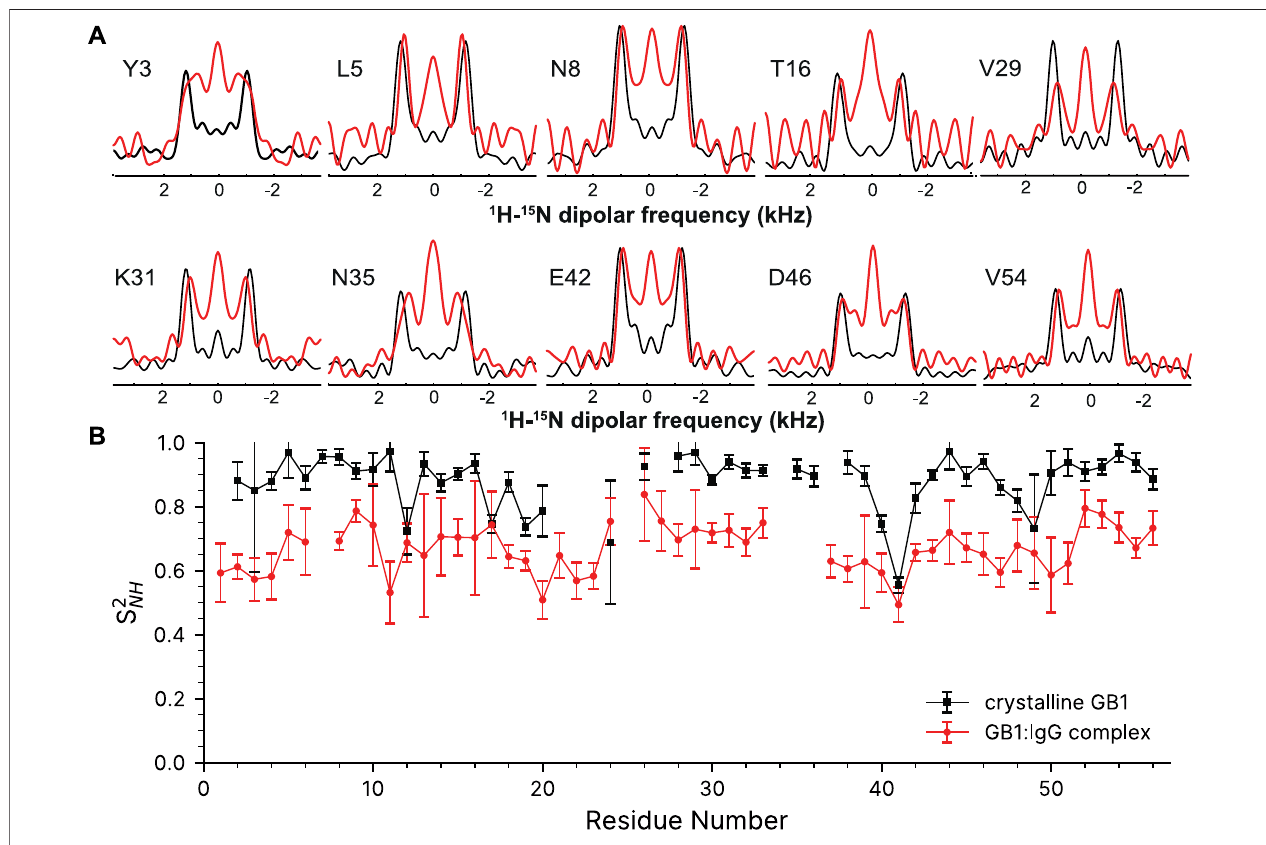
FIGURE6| 15 N- 1 HdipolarorderparameterdataforGB1inacrystal(blackline)andinaprecipitatedcomplexwithIgG(redline). (A) Overlayofrepresentativedipole recoupling spectra. (B) 15 N- 1 H order parameters as a function of residue, error bars are drawn at 1 σ . Both data sets were recorded at the nominal temperature of 263.2 K corresponding to sample temperature of ∼ 302 K at 60 kHz spinning